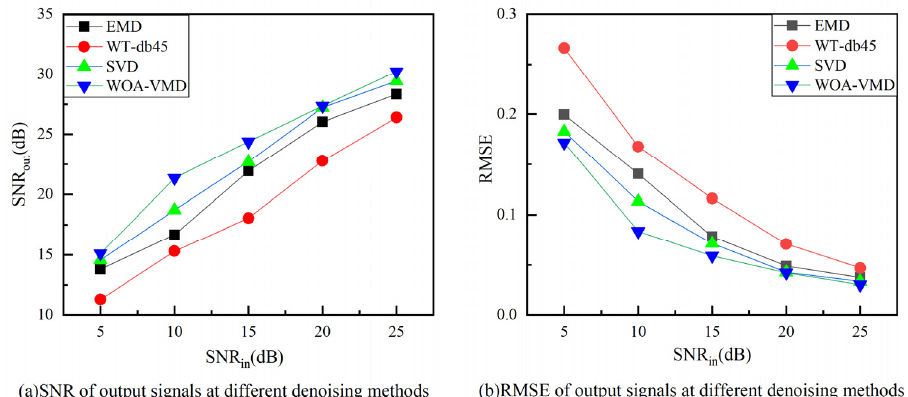
Figure 5. Comparison of the performance of different denoising methods in regards to different noisy signals.